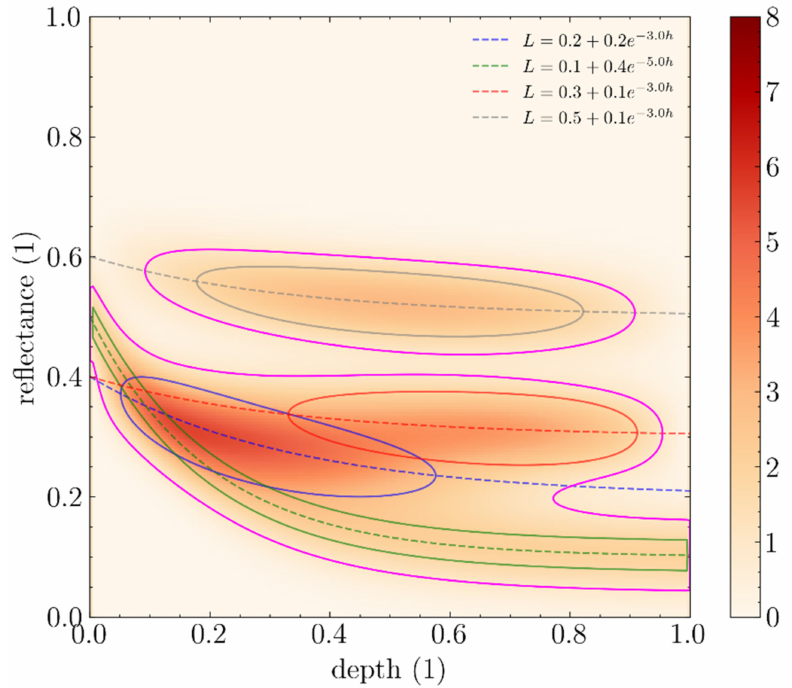
Figure 17. Example of a BNP mixture with four components.